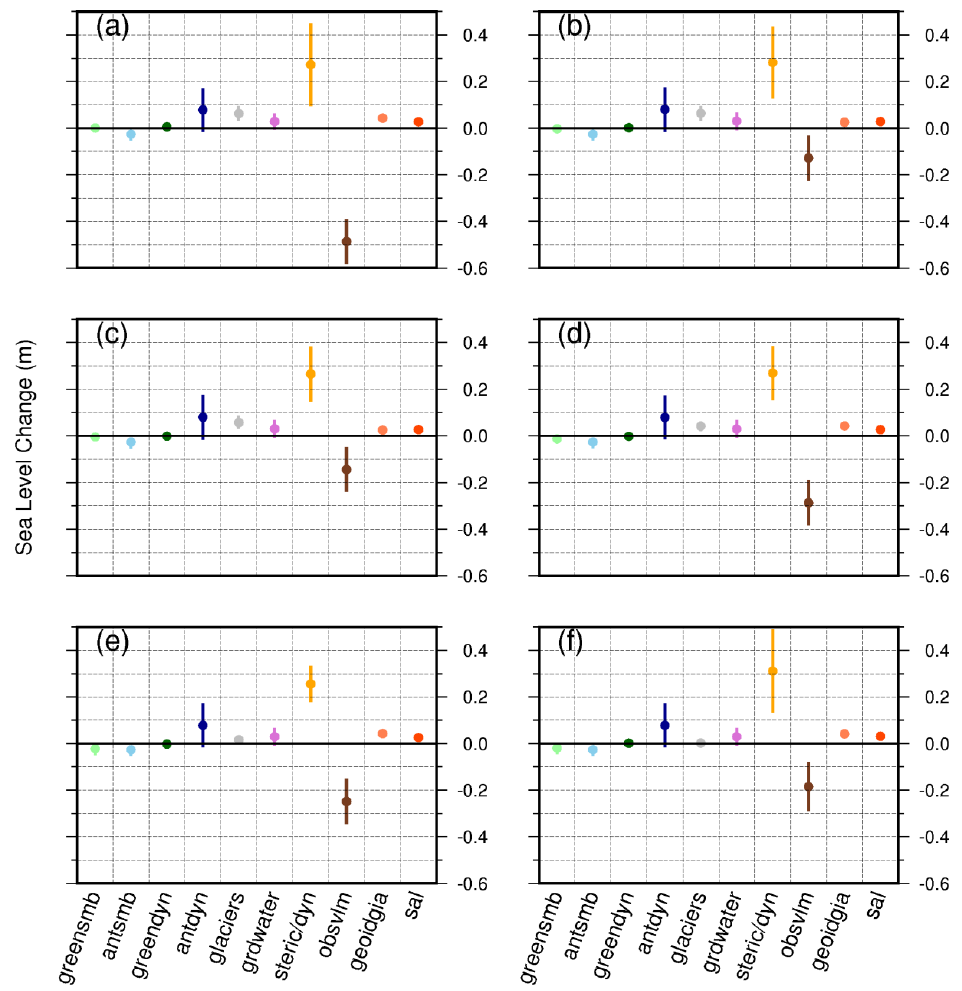
Figure 8. Contributions to projected relative sea-level change for RCP4.5 over the period 1986–2005 to 2081–2100 for the six key locations: ( a ) Oslo; ( b ) Stavanger; ( c ) Bergen; ( d ) Heimsjø; ( e ) Tromsø; and ( f ) Honningsvåg. The ensemble mean and spread (5% to 95%) are shown by the circles and vertical bars, respectively.